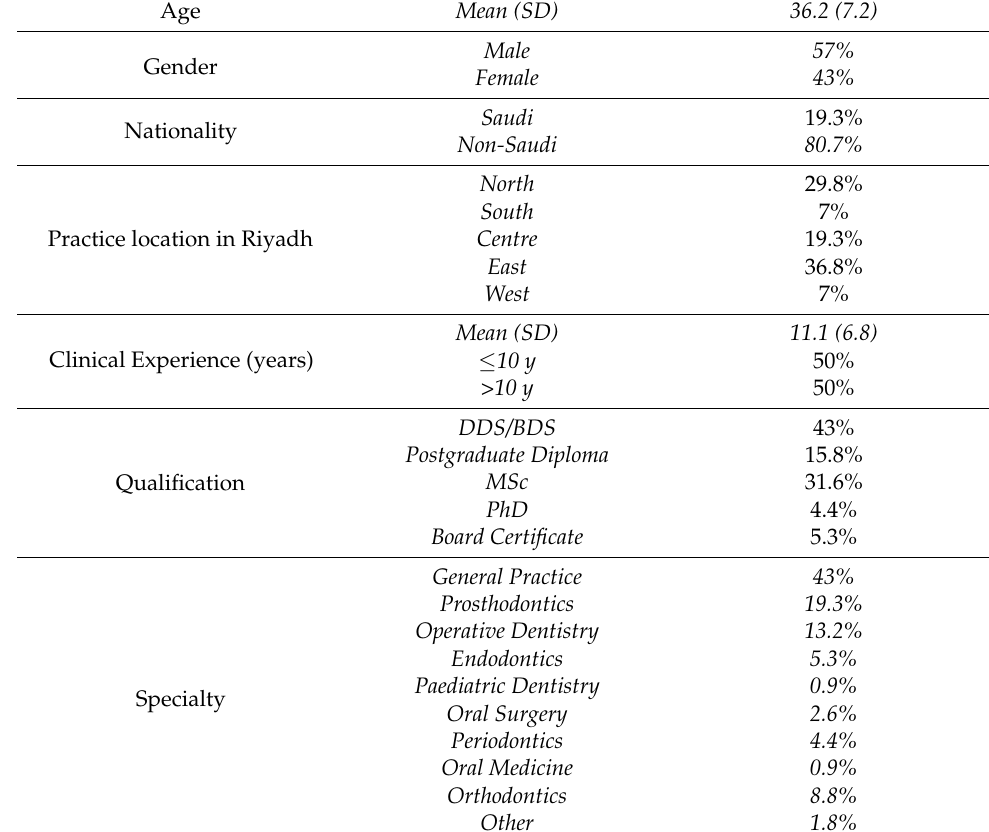
Table 1. Characteristics of participating dentists (No. = 114).